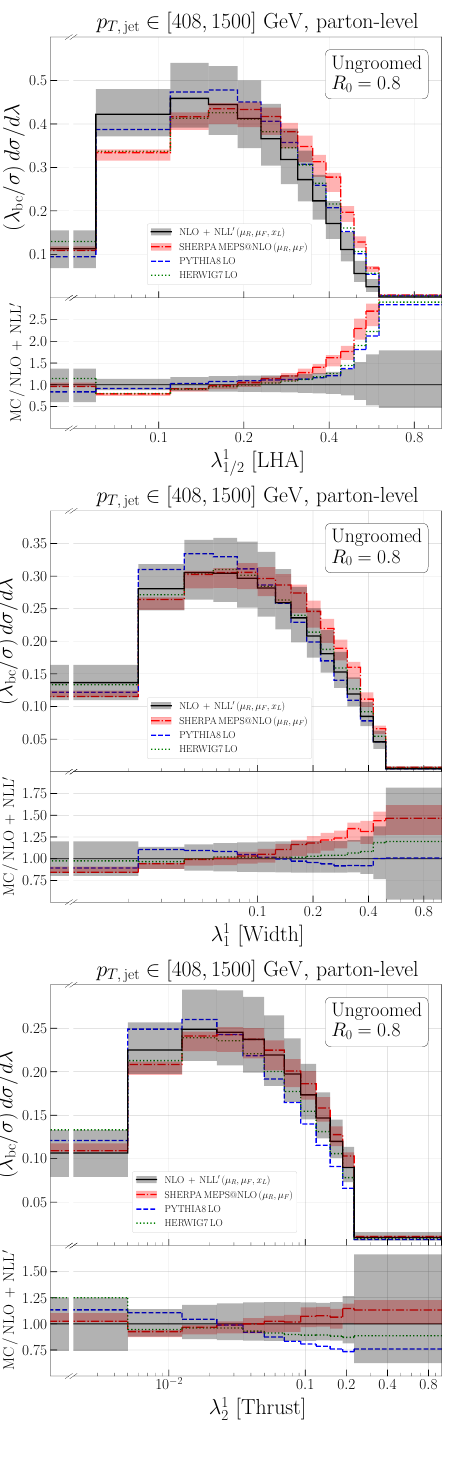
Figure 11 . Comparison of parton-level predictions for ungroomed and groomed jet-angularities in Zj production from P YTHIA , H ERWIG (both LO), and S HERPA (MEPS@NLO) with NLO + NLL 0 results for p T, jet ∈ [408 , 1500] GeV. Here λ bc stands for the bin